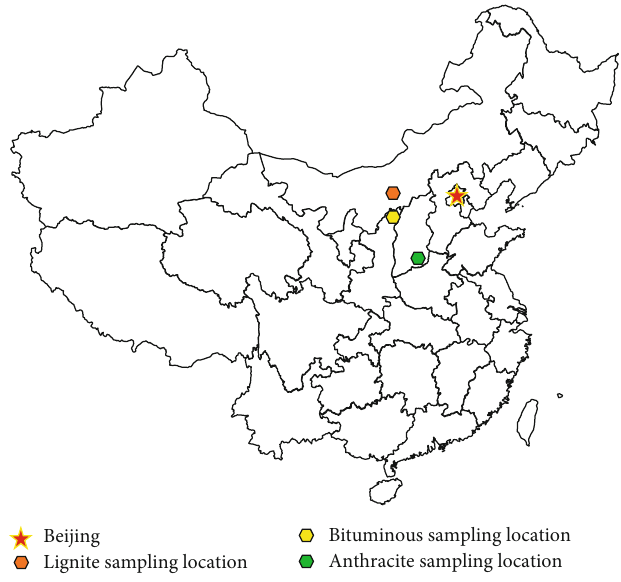
Figure 4: Sampling locations of experimental coal samples. Table 1: Proximate analysis results of coal samples.